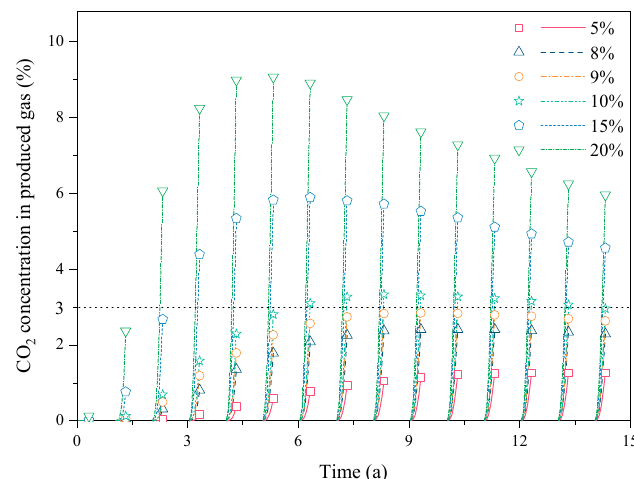
Figure 12. CO 2 concentration in the produced gas for the UGSR with di ff erent concentrations of CO 2 as cushion gas.